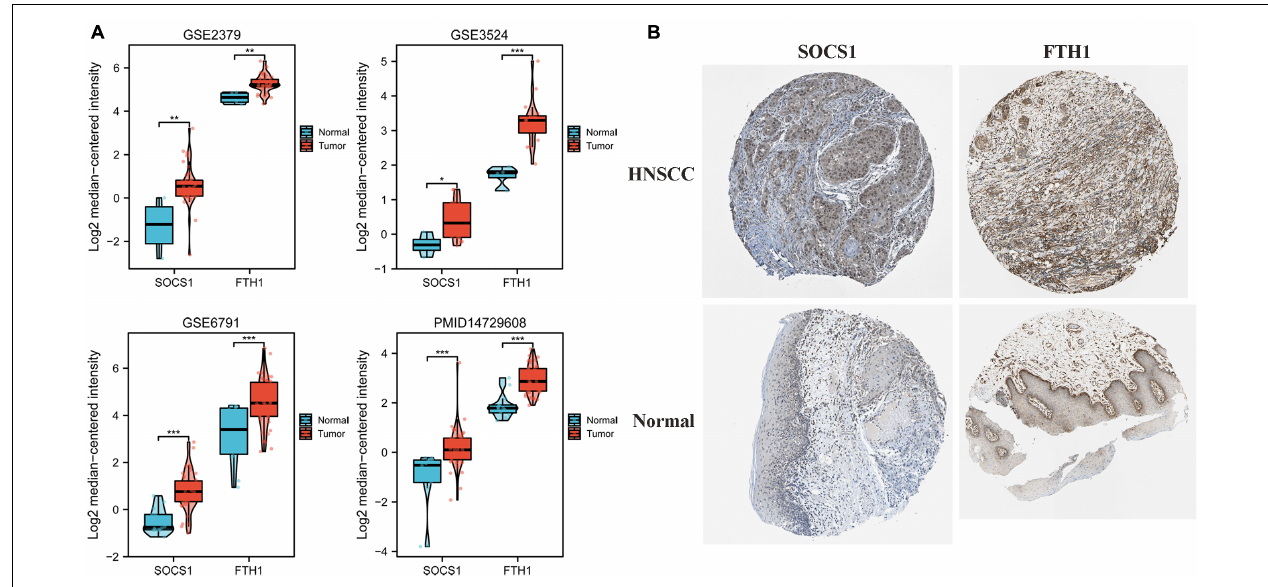
FIGURE 3 | Analysis of SOCS1 and FTH1 gene expression using Oncomine and the HPA. (A) Validation of higher SOCS1 and FTH1 gene expression levels using the datasets GSE2379 ( SOCS1 , t = 3.569, p = 0.0010; FTH1 , t = 3.168, p = 0.003), GSE3524 ( SOCS1 , t = 2.332, p = 0.0315; FTH1 , t = 4.362, p = 0.0004), GSE6791 ( SOCS1 , t = 5.449, p < 0.0001; FTH1 , t = 4.153, p = 0.0001), and PMID14729608 ( SOCS1 , t = 4.217, p < 0.0001; FTH1 , t = 5.917, p < 0.0001). (B) SOCS1 and FTH1 protein levels in HNSCC were higher in HNSCC compared with those in normal